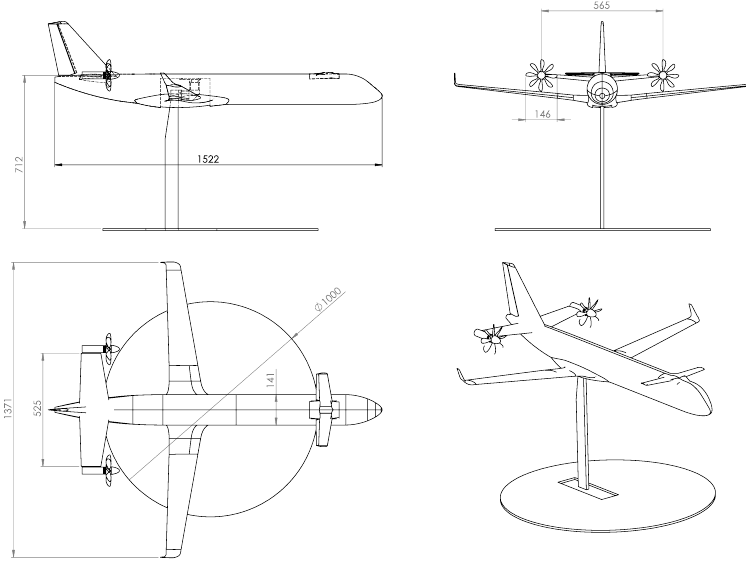
Figure 7. IRON scaled model with the main balance, motors, and propellers. Motor supporting frame not represented. Units in